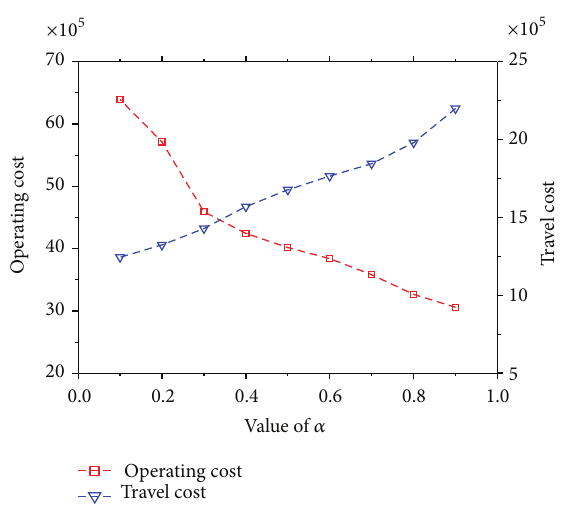
Figure 4: Relationship between objective function values and weight parameter 𝛼